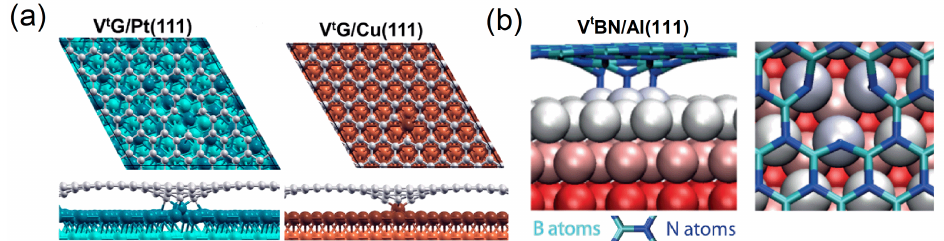
Figure 8. Top and side views of the structures for ( a ) Gr coating with point defect adsorbed on Pt (111) and Cu (111) substrates (adapted with permission from Reference [143], copyright 2017, American Chemical Society) and ( b ) h-BN coating with point defect adsorbed on Al (111) substrates (adapted with permission from Reference [145], copyright 2014, American Chemical